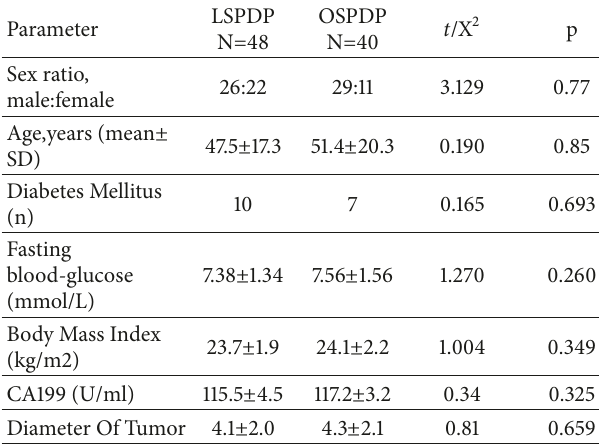
Table 1: Patient demographic characteristics of LSPDP group and OSPDP group.